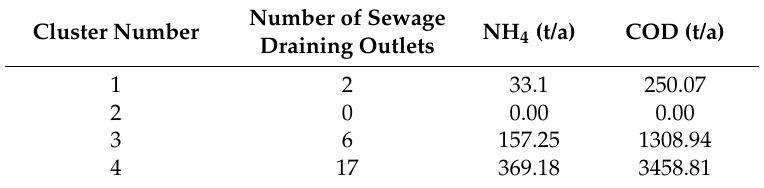
Table 6. Number of sewage draining outlets and annual emissions of NH4 and COD in each cluster. Cluster